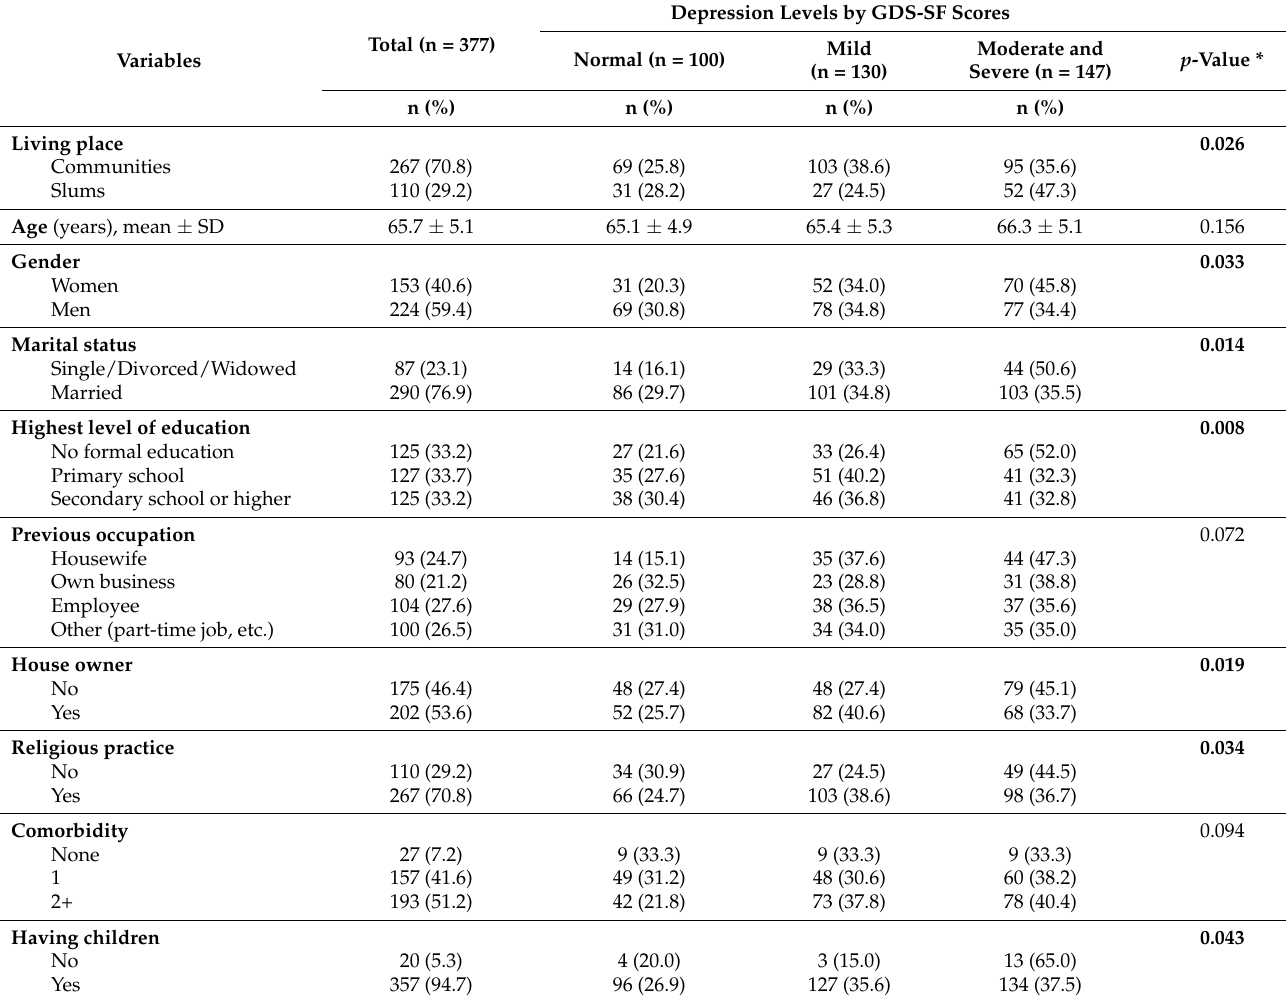
Table 1. Participants’ characteristics and depression levels (n =